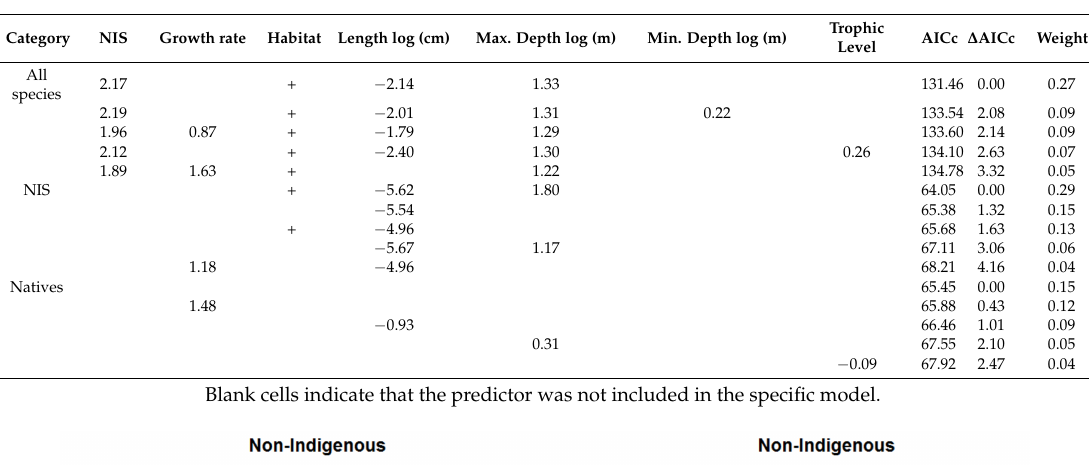
Table 2. Results of the generalized linear models, relating population trends (log ratio of relative population size between time periods) to species traits. Separate analyses were conducted for all species, non-indigenous species (NIS), and native species. The five models with the lowest Akaike’s information criterion (AICc) are shown. For continuous predictors, numbers in the table represent their regression coefficient.